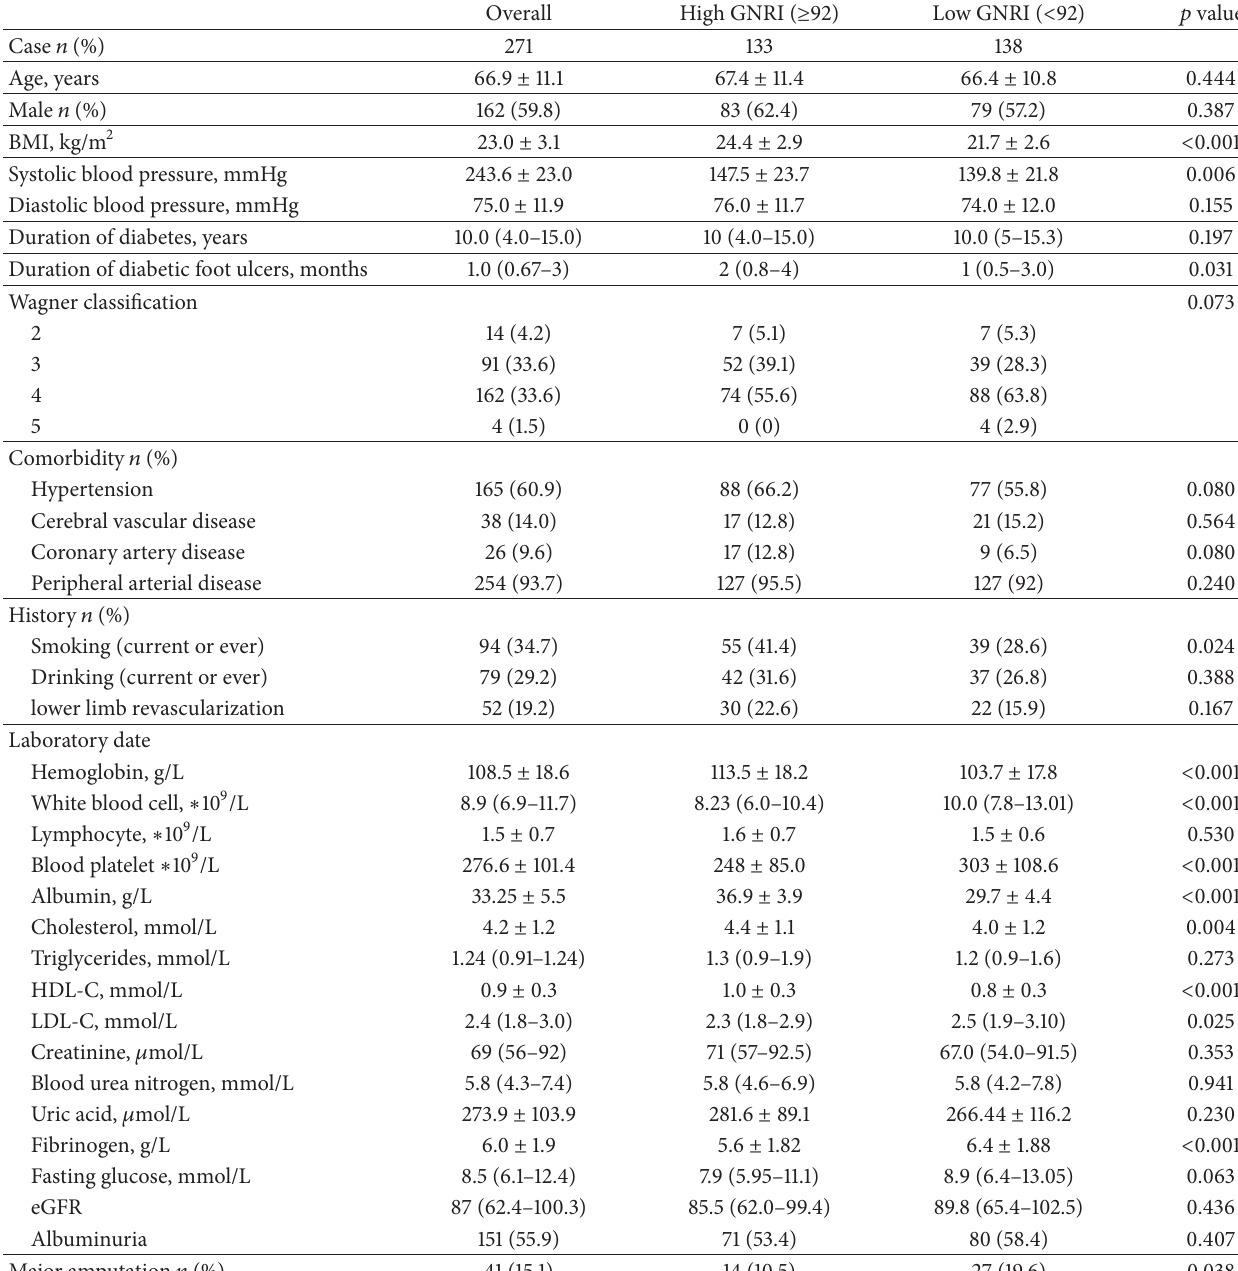
Table 1: Baseline patient